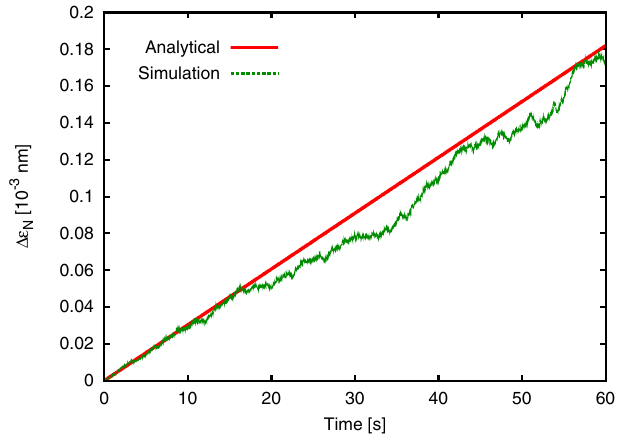
FIG. 11. (Color) Average emittance growth during 1 min (9000 pulses) for 50 random seeds. Only ground motion and feedbacks with ideal BPMs were included. The optimized feed- back system used 30 BPM patterns (all 1324 BPMs) and was constructed using 80 correctors. The corresponding trajectory control performance is shown in Fig. 12. the feedback system can run for 830 minutes. This means that the optimized feedbacks could possibly control the ground motion for almost 14 hours. The analytical results and results of simulations of 50 machines are shown in Figs. 11 and 12.